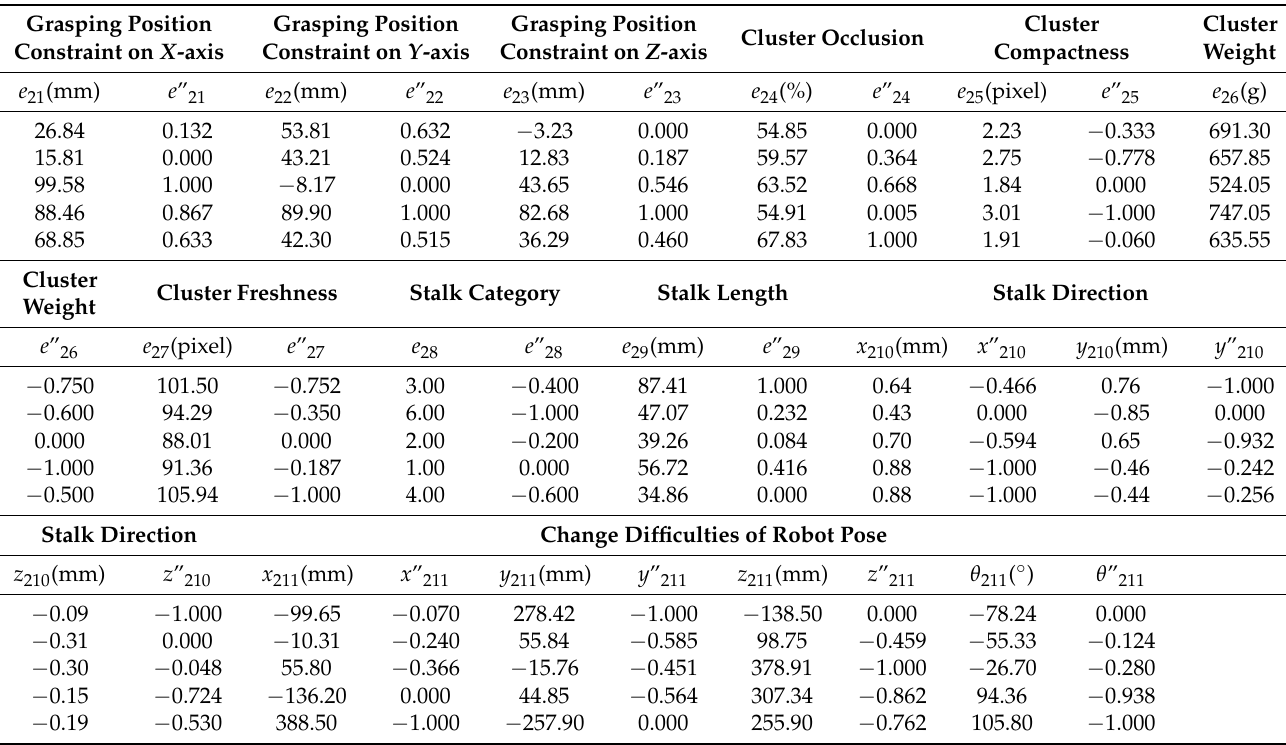
Table 3. Experimental data with main differences of stalk